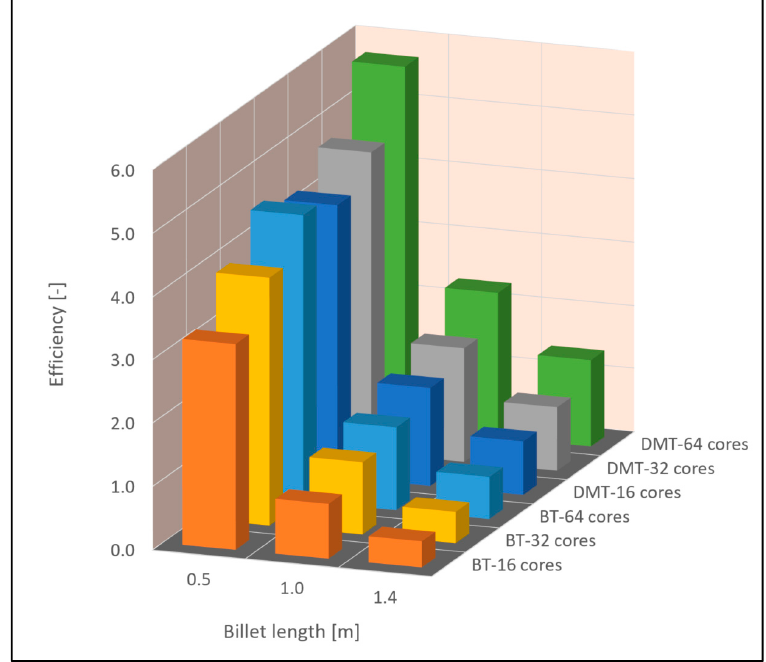
Figure 7. Comparison of numerical efficiency for three billet lengths and different number of cores between DMT and BT.